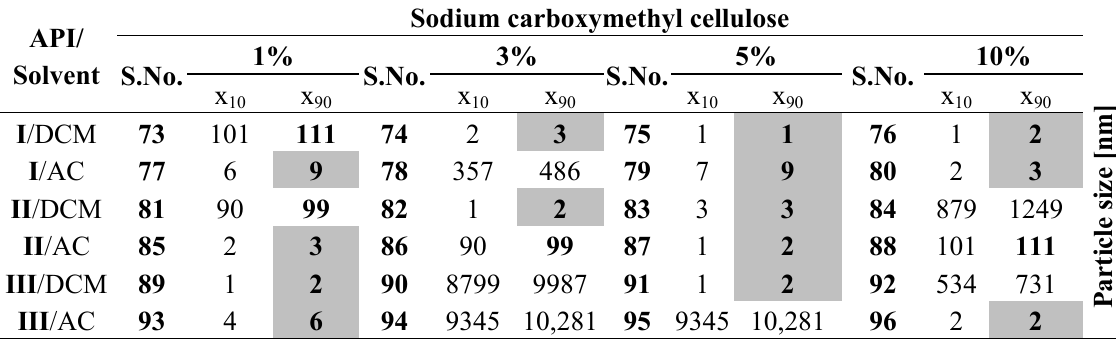
Table 5. Particle size (x , x [nm]) of APIs I – III and concentration [%] of sodium 10 90 carboxymethyl dextran in dichloromethane (DCM) or acetone (AC). All the presented